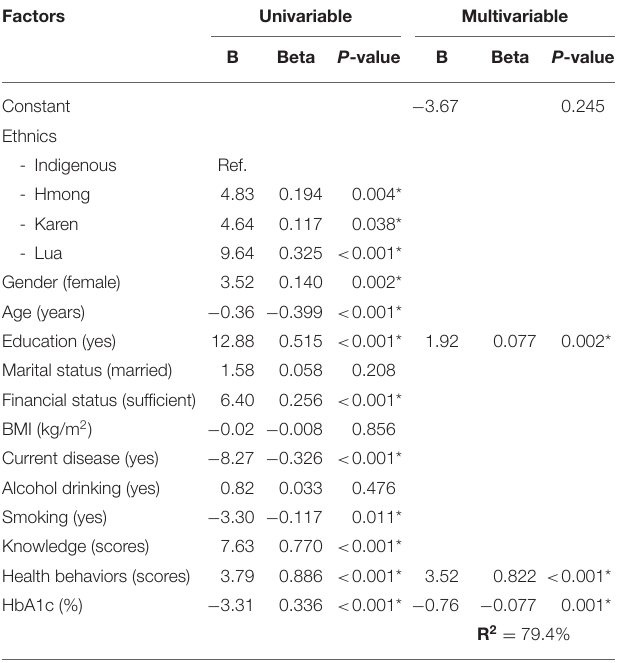
TABLE 5 | Factors associated with QoL in agricultural workers by linear regression ( n = 468).